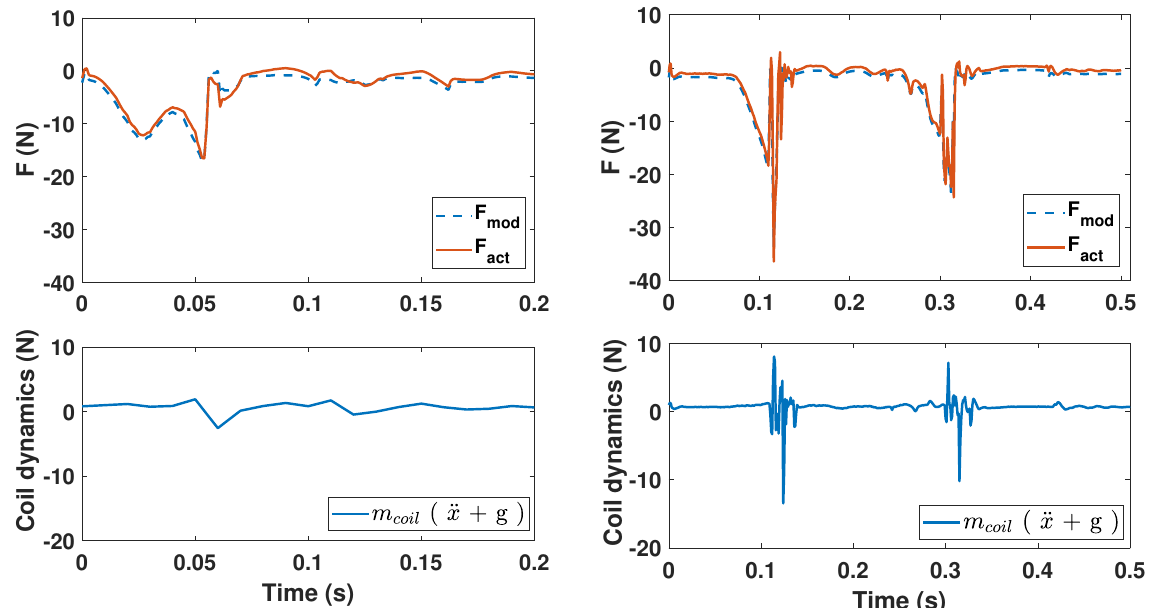
Figure 13. Results for the two considered force profiles using FEM simulations.